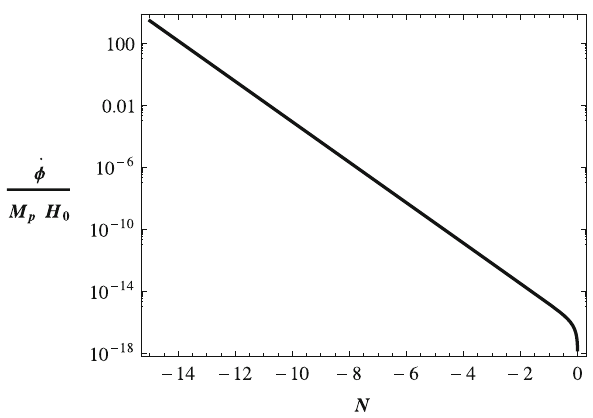
˙ φ plotted against the number of M P H 0